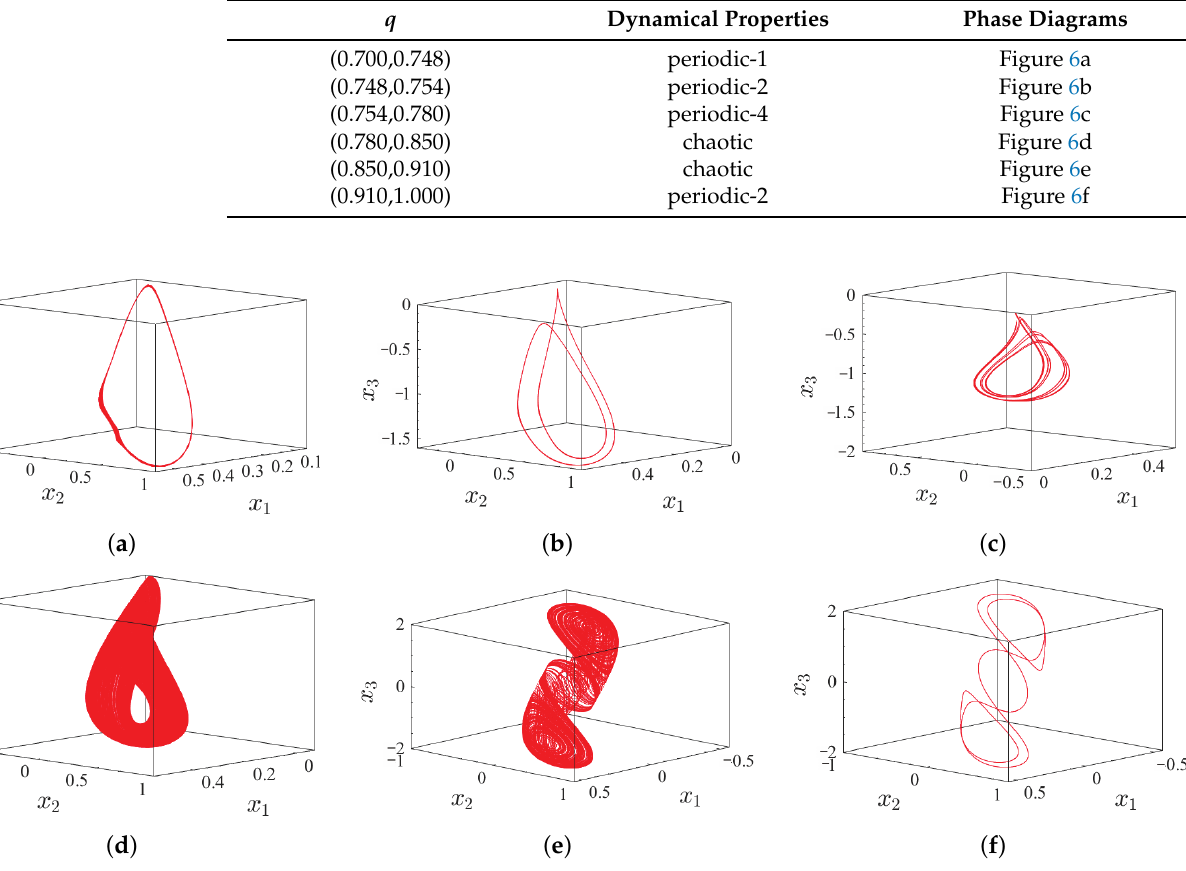
x 2 x 3 plane. ( a ) Period-1 of q = 0.71; ( b ) period-2 − −